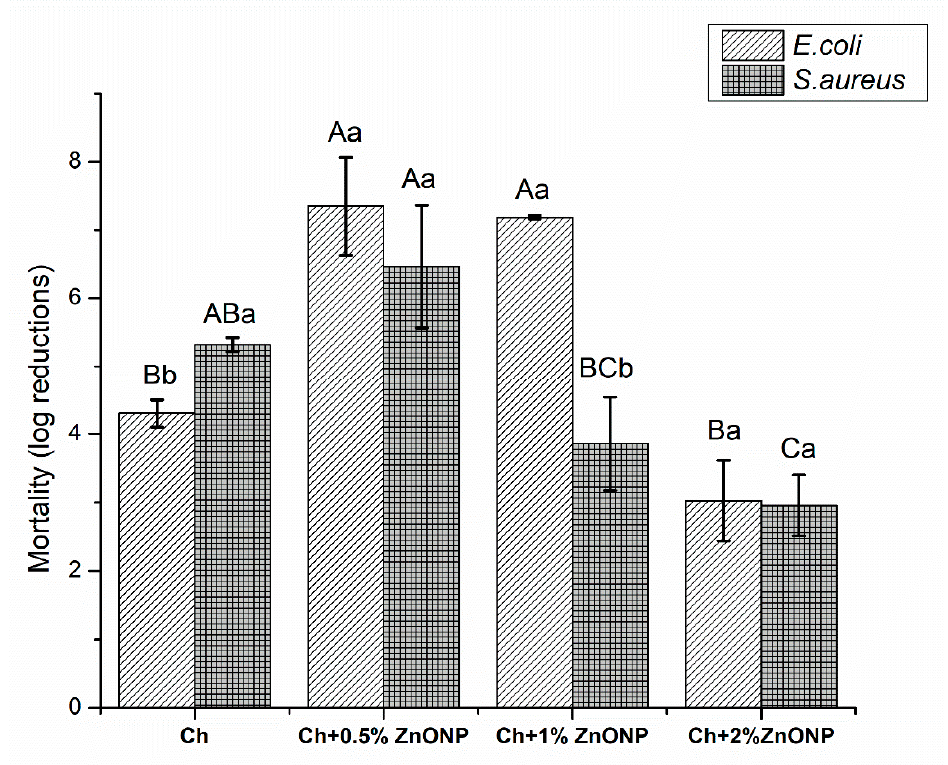
Figure 2. Bionanocomposites in vitro antimicrobial activity. (A-C) : Within each bacterium, values not sharing upper case superscript letters indicate statistically significant differences among formulations ( p < 0.05); (a–b) : Within each formulation/treatment, values not sharing lower case superscript letters indicate statistically significant differences among bacteria ( p < 0.05). Chitosan (Ch), zinc oxide nanoparticles (ZnO NPs).